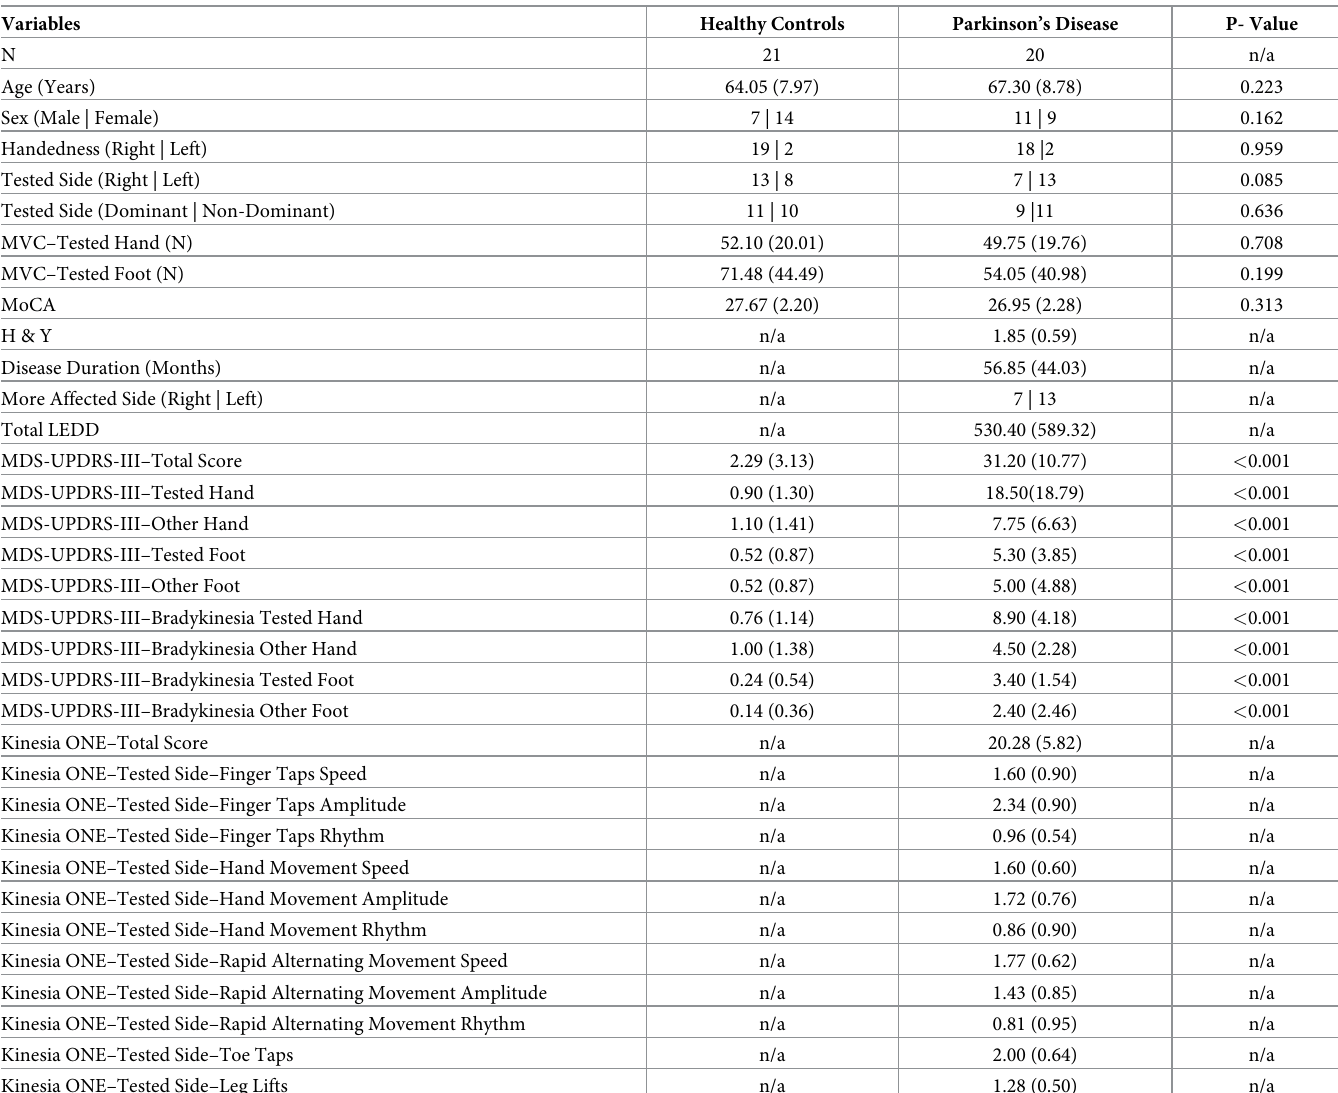
The table lists the sociodemographics, clinical characteristics and several behavioral measures for the two groups. The last column lists the p -values of the statistical analyses described in the “Statistical Analysis” section. Data represent the count or mean ± 1 standard deviation (SD). Of note, all tests were completed by the PD patients in the “off” state, following an overnight withdrawal from medication. Disease duration is defined as time since diagnosis. Kinesia ONE scores for the tested side are reported. The Kinesia ONE total score is the sum of all items (left + right side items listed in the table plus scores for rest tremor, postural tremor, kinetic tremor, gait, and dyskinesia). Abbreviations: H & Y = Hoehn and Yahr Staging Scale; LEDD = levodopa equivalent daily dose; MoCA = Montreal Cognitive Assessment; MDS-UPDRS-III = the motor section of the Movement Disorder Society Unified Parkinson’s Disease Rating Scale; mg = milligram; MVC = maximum voluntary contraction; N =